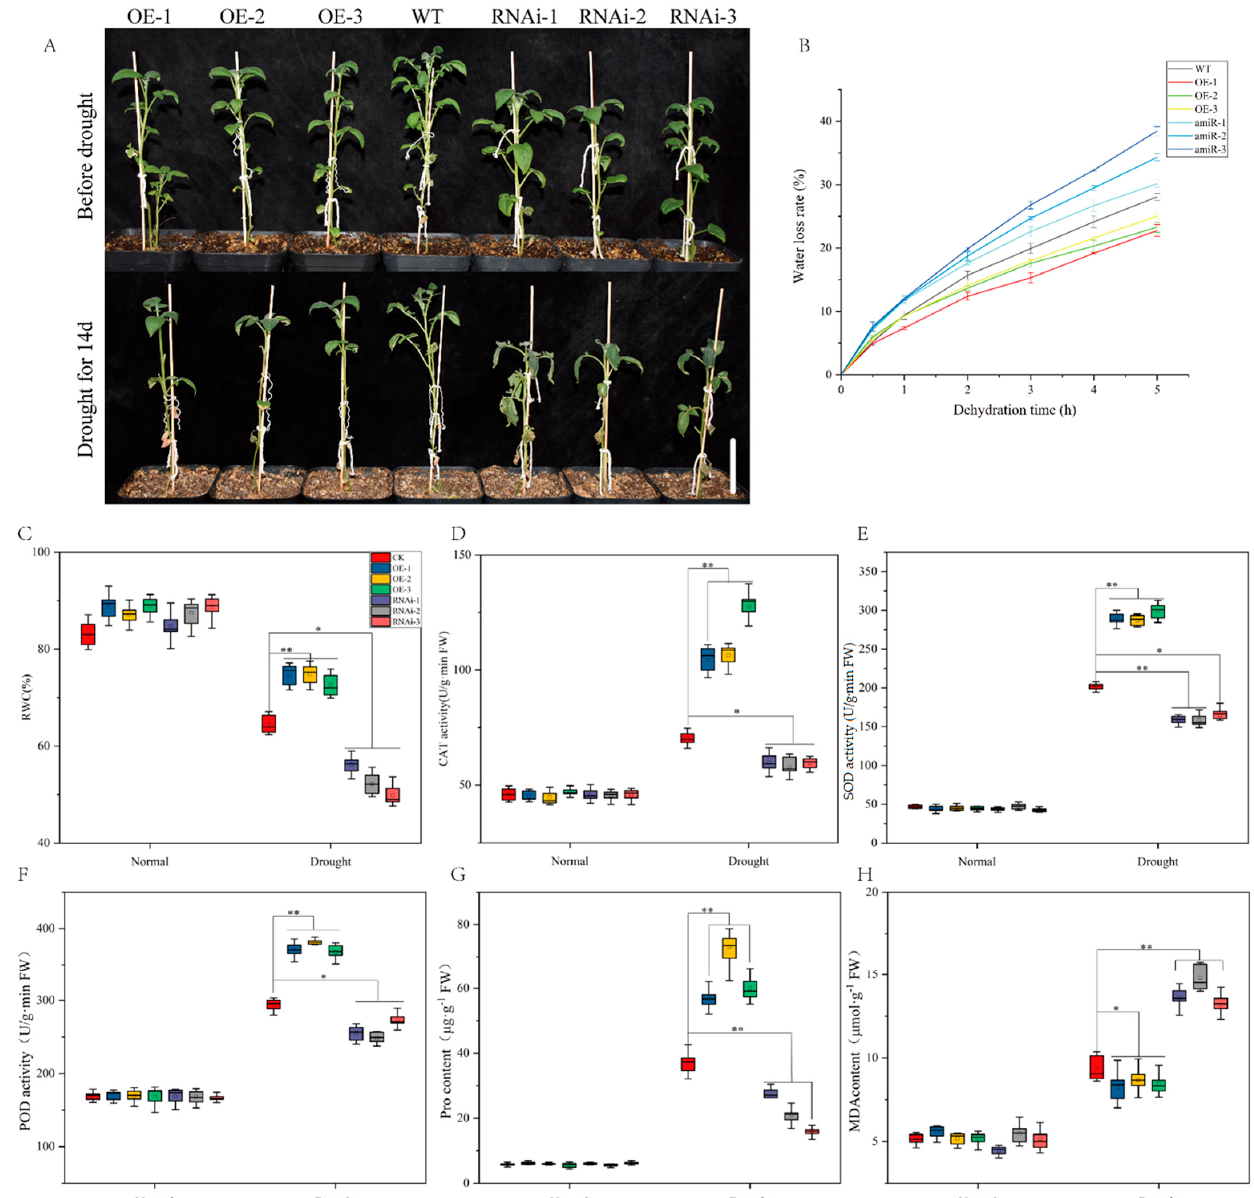
Figure 5. Overexpression of StCIPK18 improved drought tolerance after 14 days of water deficiency. ( A ) Phenotypic differences between WT, OE-StCIPK18 and RNAi-StCIPK18 lines after 14 days of water deficiency. The scale bale represents 10 cm. ( B ) Water loss from detached leaves. ( C ) Leaf relative water content under non-stress and drought conditions. ( D ) CAT activity. ( E ) SOD activity. ( F ) POD activity. ( G ) Proline content. ( H ) MDA content. Each column represents the mean values SE ( n = 3; * p < 0.05; ** p < 0.01).